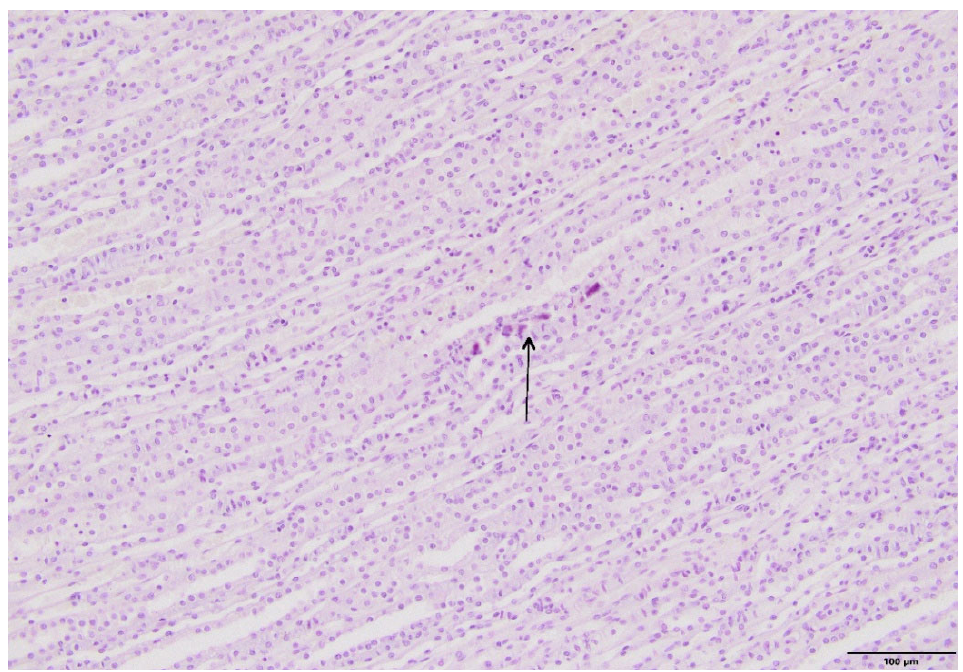
Figure 1. Pathological lesions in kidneys of rats on 10% fructose diet (F10). The purple concretions within the interstitium and tubules with ring ‐ like substructures (arrow). The deposits are non ‐ po ‐ larizable, displacing the proximal tubule epithelium and narrowing the lumen. (HE, magnification 20×).